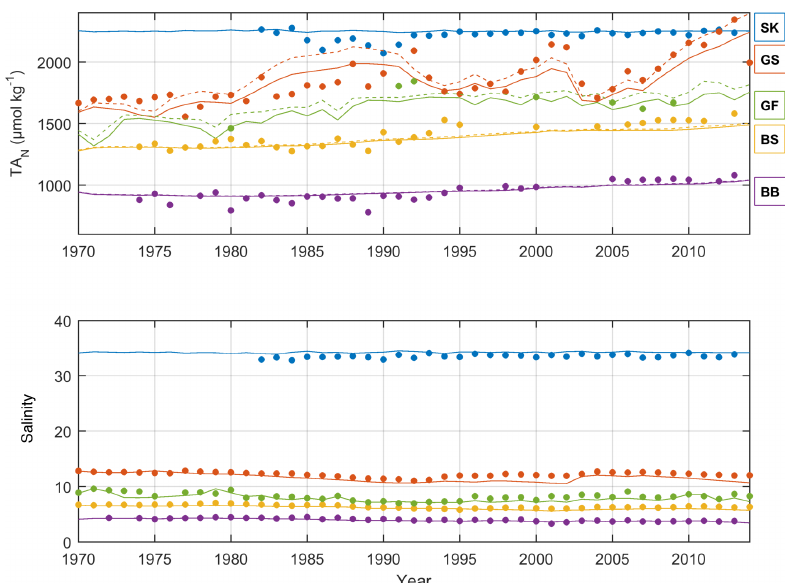
Figure 6. Annual mean observed (dots) and modeled (lines) normalized deep water TA (TA N , µmolkg − 1 ) and salinity in five sub-basins. Full and dashed lines represent the scenarios in which the unresolved TA sources are added as land loads or sediment release, respectively. Model data from sub-basins 3 (SK), 9 (GS), 10 (BS), 11 (BB), and 13 (GF) are compared to observed data at the Anholt East, BY15, US5B, F9/A13, and LL7 stations,